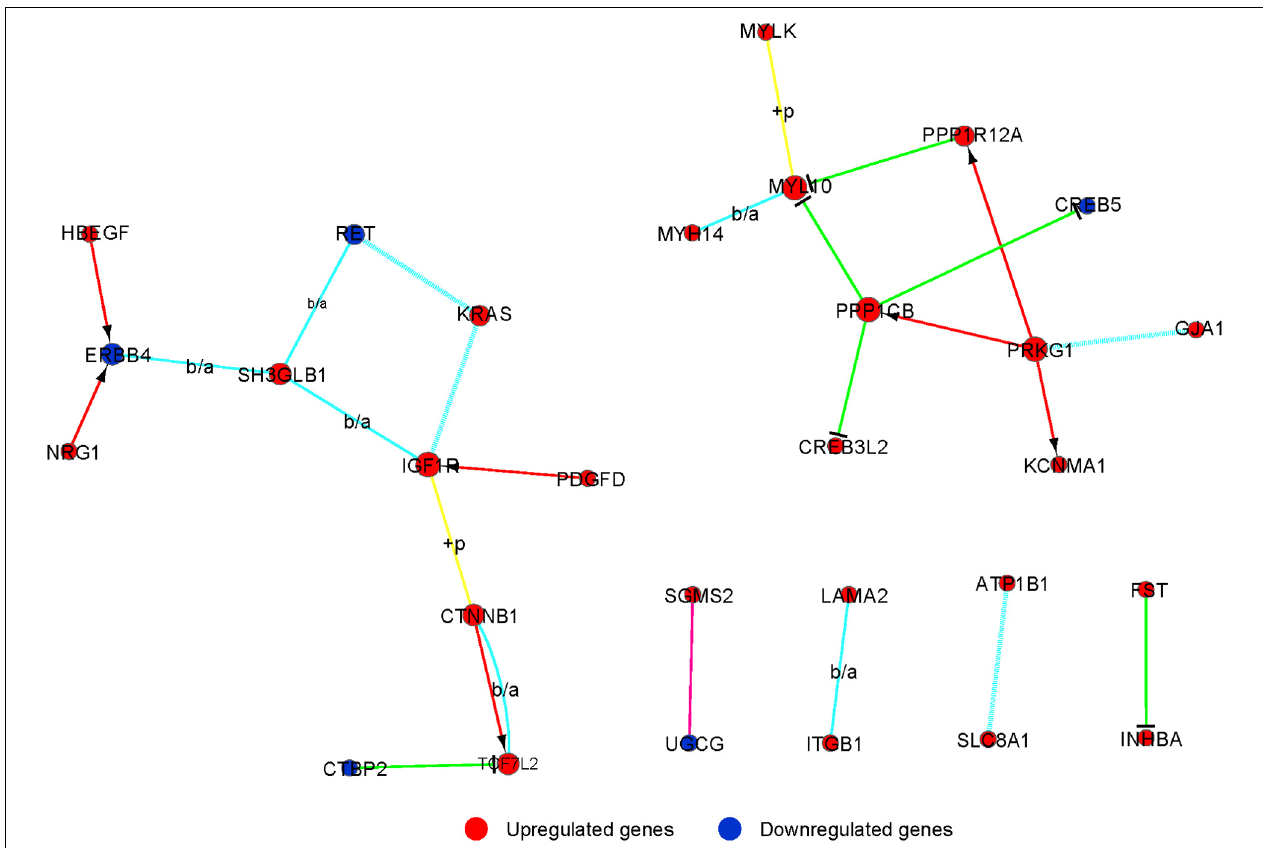
FIGURE 5 | The interaction network of differently expressed gene (signal-net) analysis during chondrogenic differentiation. The color and shape of lines indicate interactions between